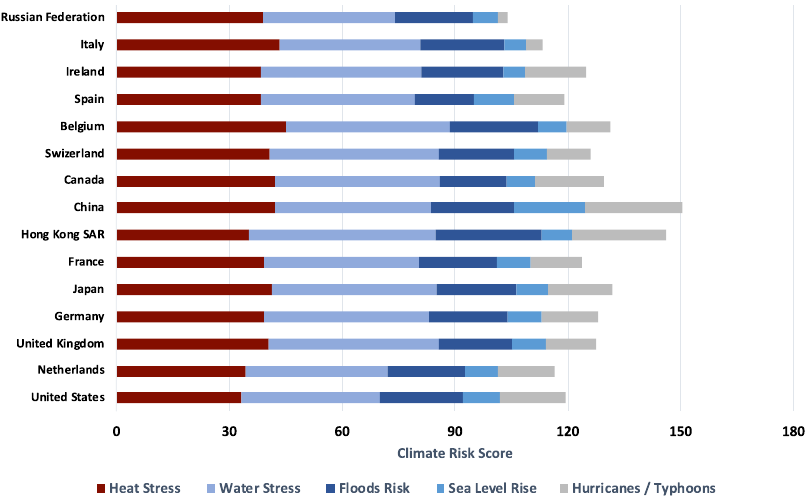
Fig. 4 Average climate risk scores of overseas facilities by headquarters country: top 15 countries by FDI out fl ow stock, 1970 – 2019. Analysis based on climate risk scores and facility statistics of 2233 public companies from Four Twenty Seven. FDI out fl ow stocks based on World Bank data.